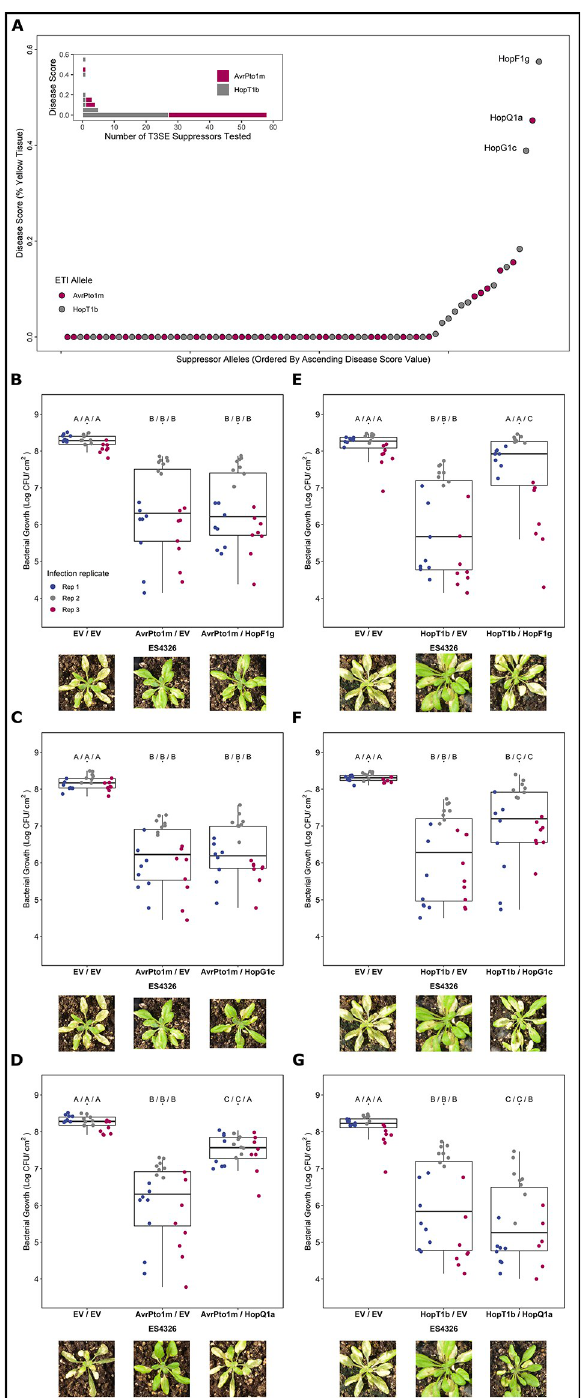
Fig 4. Identification of PtoDC3000 ETI suppressing effectors. (A) Plant disease scores obtained from strains used to identify suppressors of AvrPto1m- and HopT1b-associated ETIs. PmaES4326 strains harboring the ETI elicitor (on the MCS2 vector) and the PtoDC3000 candidate suppressor allele (on the pUCP20TC vector) were used for spray inoculation. Plant disease scores were determined by plotting percent chlorosis [43] within the bounds of the positive ETI control (MCS2::ETI pUCP20TC::EV, disease score = 0.0) and the negative ETI control (MCS2::EV pUCP20TC:: EV, disease score = 1.0). Validation of identified ETI suppression phenotypes of (B-D) AvrPto1m and (E-G) HopT1b through bacterial growth assays. Letters represent statistically significant differences (Tukey’s HSD, P < 0.05).